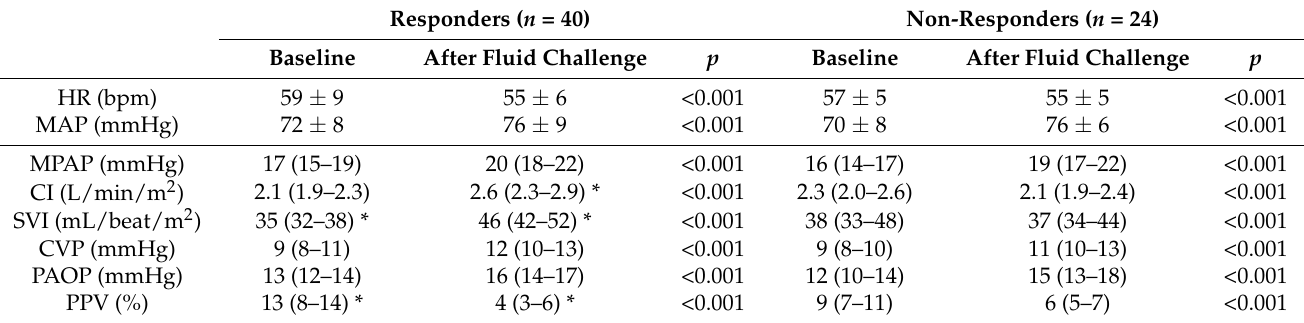
Table 2. Hemodynamic variables and invasive preload indices at baseline and after fluid